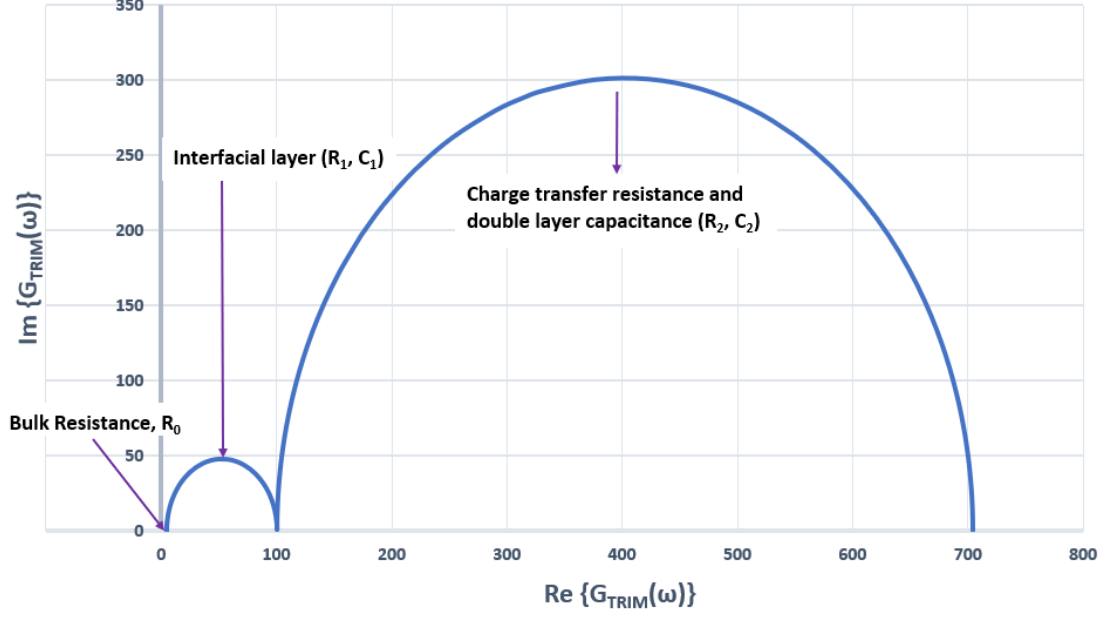
Figure 11. Nyquist diagram of the Trimethoprim/Sulfamethoxazole model.